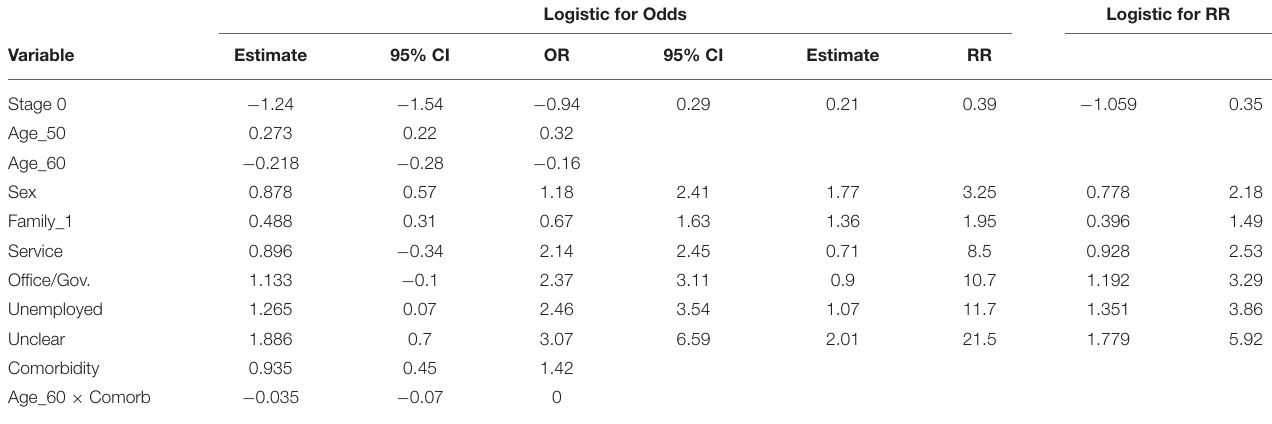
TABLE 8 | Results from ordinary stepwise and modified logistic models. Logistic for Odds Logistic for RR